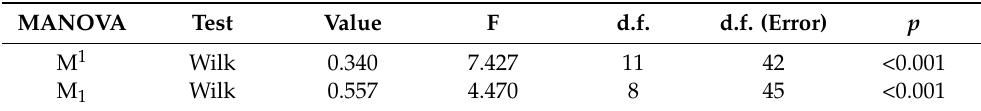
Table 4. Variations in the first molars outline of K14Cre;Jagged1 fl/fl mice. Multivariate analysis of variations (MANOVA) indicates significant differences in the first molars outline between WT and K14Cre;Jagged1 fl/fl